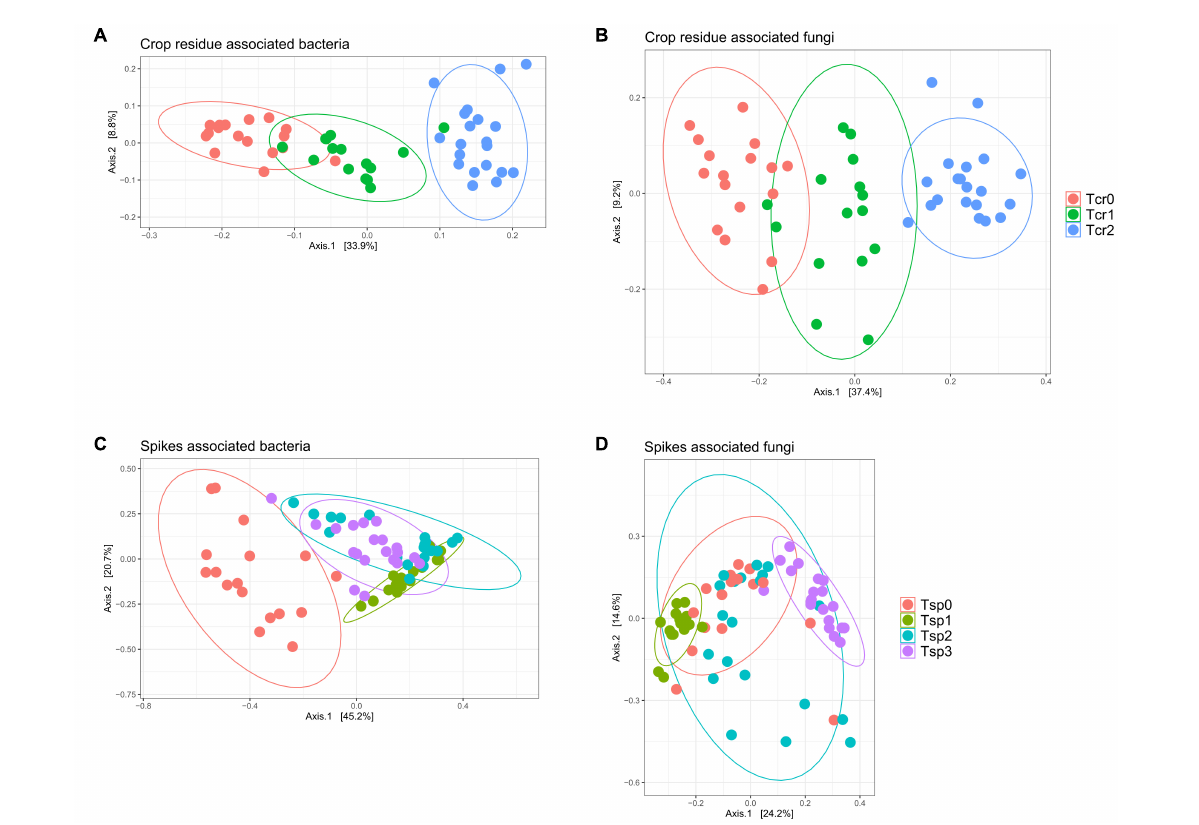
FIGURE6 Microbiomes associated with wheat tissue demonstrate progressive change over time. Plots are principal coordinates ordinations derived from pairwise community dissimilarity values (Bray-Curtis index). (A) Bacterial communities from crop residue; (B) fungal communities from crop residue; (C) bacterial communities from wheat spikes; (D) fungal communities from wheat spikes. See text for a complete description of the sampling time points (T cr 0, T cr 1, T cr 2; T sp 0, T sp 1, T sp 2, T sp 3). Ellipses represent a 95% confidence